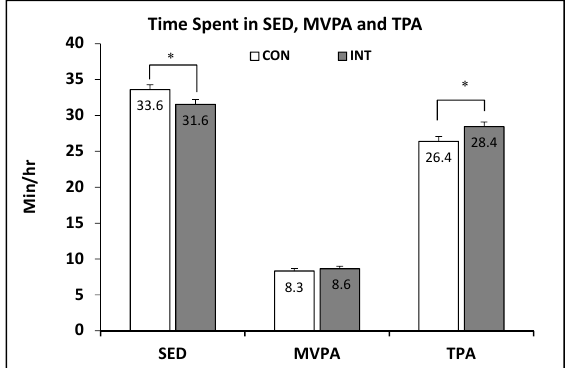
Figure 3. Average Time Spent in Sedentary Behavior Between Children Attending the CON and the INT Preschools. * Difference between the CON and the INT preschools adjusted for age, sex, race, parent education, parent perception of child’s PA, BMI and childcare centers ( p < 0.05); Bars, standard error. The results of teacher and parent surveys for the acceptability of the intervention are shown in Table 2. Both teachers and parents had very positive perceptions of the intervention, with the item mean scores ranging from 3.8 to 4.7 on a 5-point scale. On average, teachers in the intervention group checked children’s PA four times using the real-time monitoring system throughout the day and reported the intervention was effective and feasible for promoting PA in their classroom settings. Parents in the intervention group rated the intervention very adequate and effective and wearing Fitbit activity tracker very easy and enjoyable for their child. Table 2. Evaluation of Intervention Feasibility by Classroom Teachers and Parents, Mean ± SD or Percent. Variables Score Range (1–5)